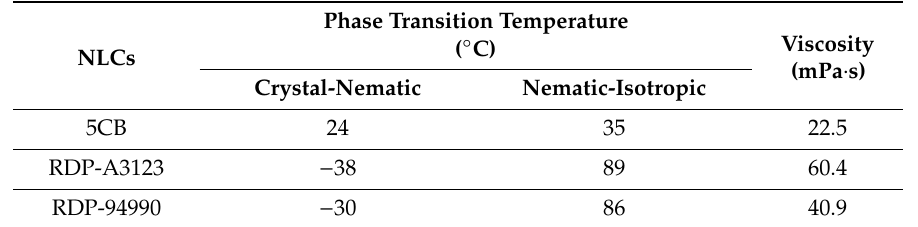
Table 1. Phase transition temperatures and viscosities of the nematic LCs (NLCs); 5CB, RDP-A3123, and RDP-94990.